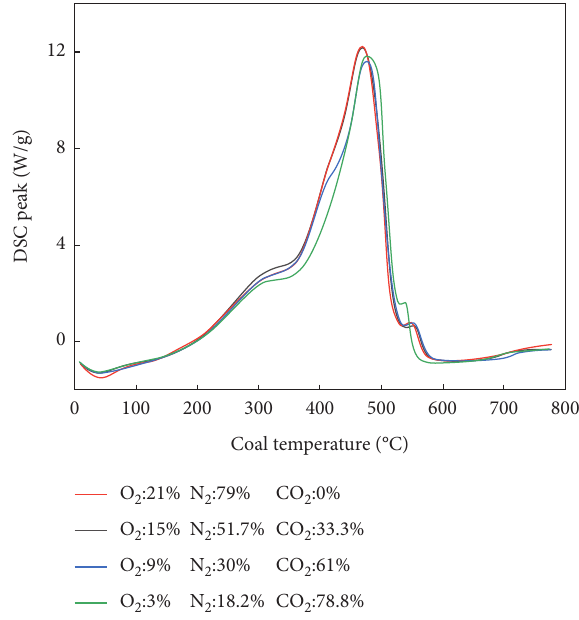
Figure 11: Pressure drop in the tube furnace vs. time at CO (b) 40 ° C, and (c) 50 ° C upon CO 2 adsorption.